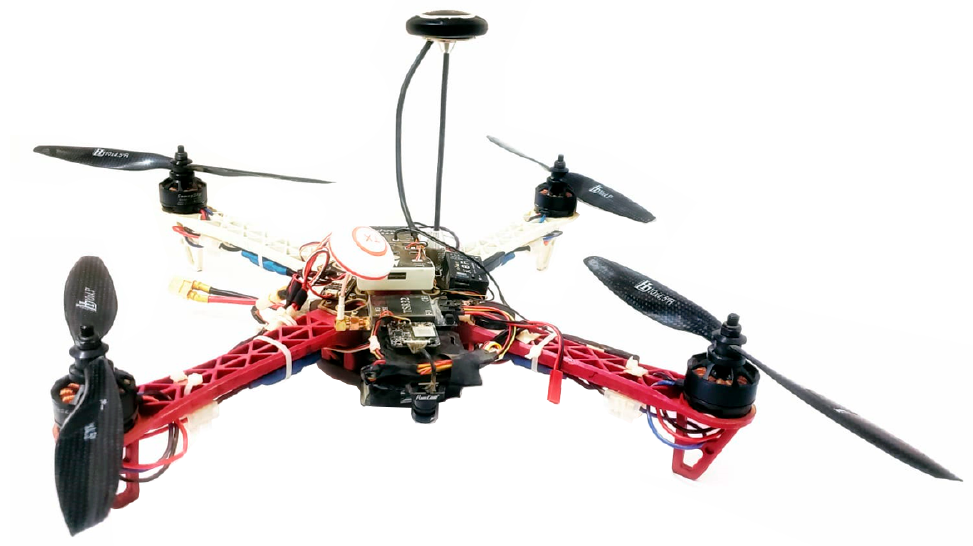
Figure 20. Quadrotor used in the experimental